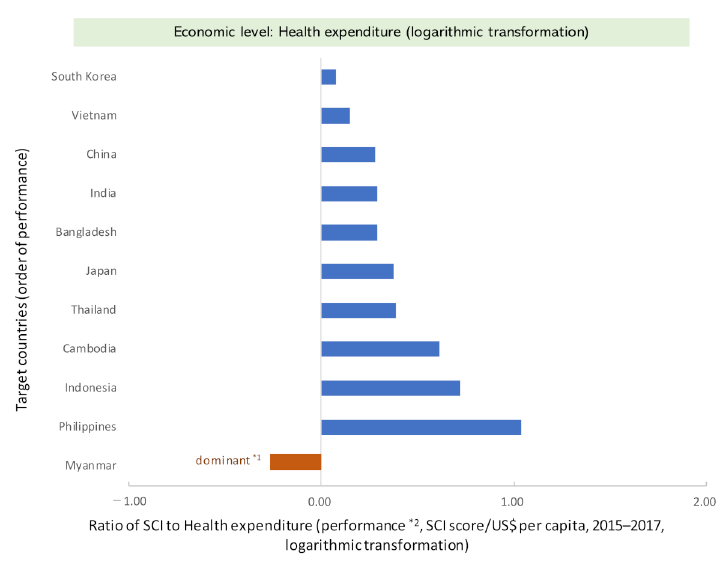
Figure 4. Performance status by country (broad cost-effectiveness analysis, based on displacement from 2015 to 2017). ( Top ) Note: SCI, service coverage index. *1: Dominant is positioned in a more cost-effective dimension with increasing outcomes (SCI) even if the economy (GDP) declines. *2: The performance was a cost-effectiveness analysis (difference in outcome “SCI” ÷ difference in economy “GDP”; displacement from 2015 to 2017). Both indexes were logarithmically transformed in consideration of elasticity. ( Bottom ) Note: SCI, service coverage index. *1: Dominant is positioned in a more cost-effective dimension with increasing outcomes (SCI) even if the economy (Health expenditure) declines. *2: The performance was a cost-effectiveness analysis (difference in outcome “SCI” ÷ difference in economy “Health expenditure”; displacement from 2015 to 2017). Both indexes were logarithmically transformed in consideration of